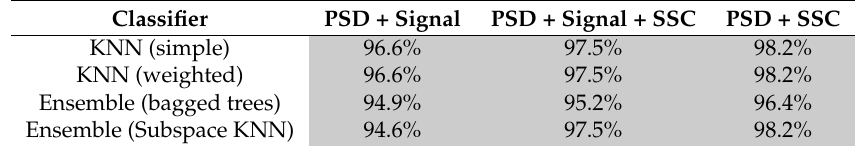
Table 4. Classification accuracy for damaged samples of 500 µ m and 600 µ m using hybrid parameters followed by PCA with 95% variance. Accuracy of better than 90% is shown in grey